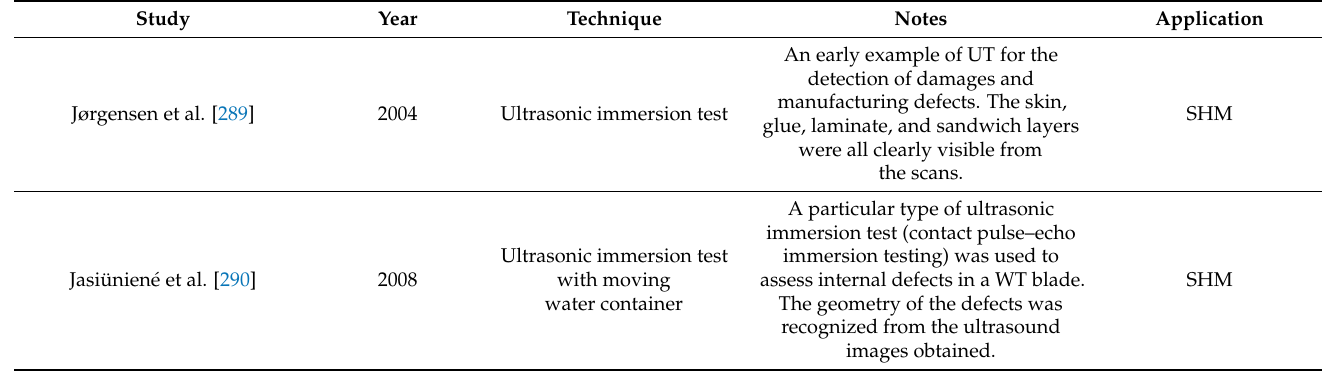
Table 9. Some notable and recent examples of IRT techniques applied for the NDE of wind